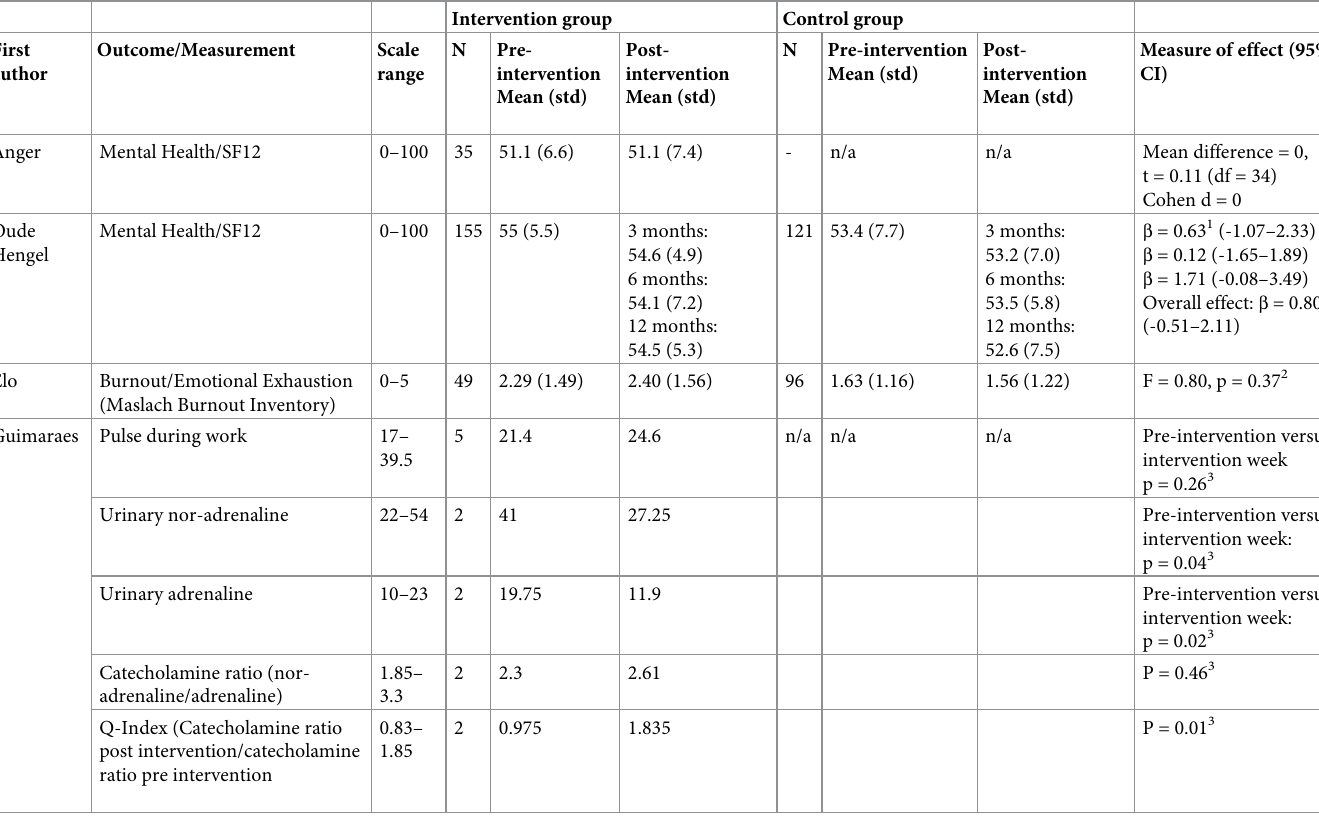
Table 5. Results of the effectiveness of mental health promotion interventions: Primary